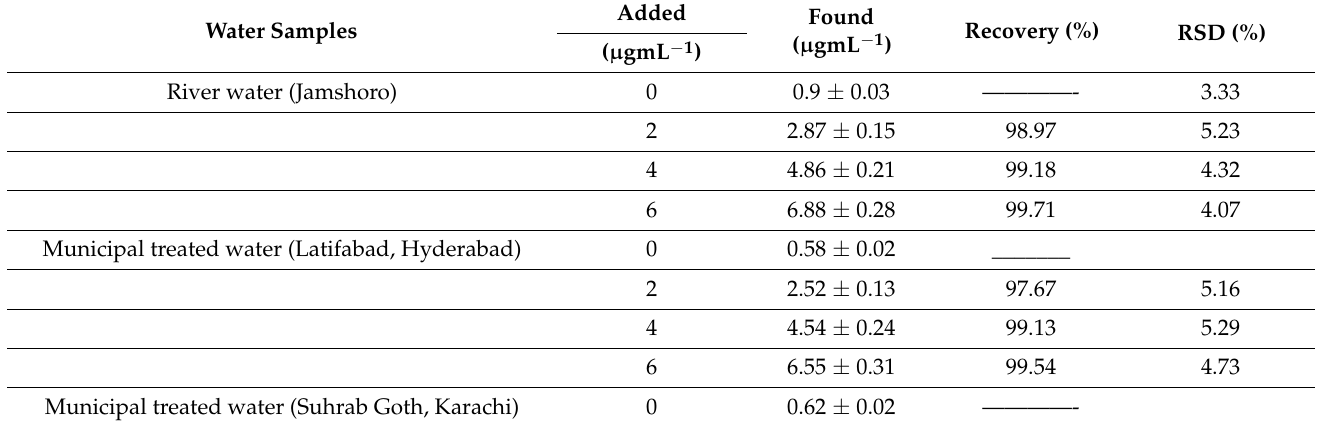
Table 3. Determination of Hg 2+ ions in real water samples (replications = 3) by calibration plot